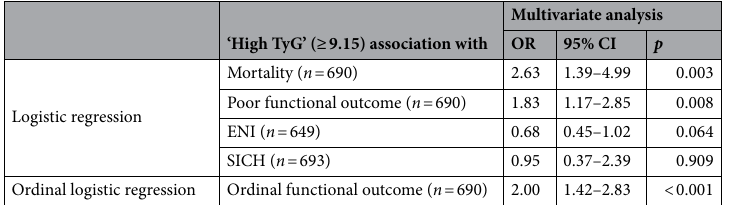
Table 4. Association of ‘High TyG’ (≥ 9.15) with outcomes including ordinal functional outcome mRS 0–6. Adjusted odds ratio, 95% confidence interval and p-value calculated from logistic regression after adjusting for hypertension, age, admitting NIHSS and LVO status. ‘High TyG’ triglyceride-glucose index ≥ 9.15, OR odds ratio, 95% CI 95% confidence interval, p p-value, poor functional outcome dichotomous outcome of modified Rankin scale of 3 to 6, ENI early neurological improvement, SICH symptomatic intracranial hemorrhage, ordinal function outcome ordinal outcomes using modified Rankin scale 0 to 6.